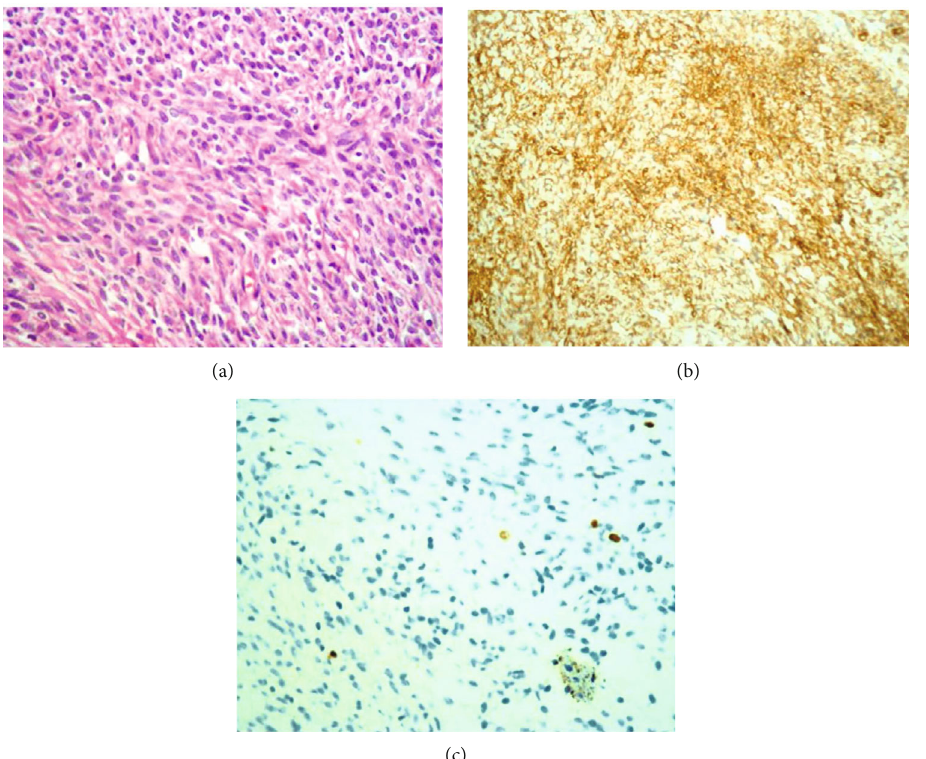
Figure 2: Pathology slides. (a) Hematoxylin and eosin staining of z200 magni fi cation reveals spindloid nuclei and thin vascular structures. (b) Di ff use staining with CD34 at × 200 magni fi cation. (c) 1-2% proliferation index with Ki-67 at × 200 magni fi